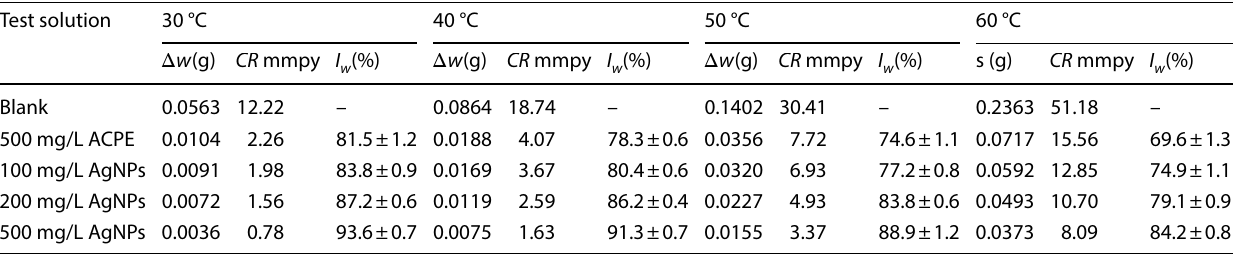
Table 5 Weight loss, corrosion rate and inhibition efficiency of Et-ACPE and Et-AgNPs against X80 steel corrosion in 1 M HCl at 30 – 60 °C Test